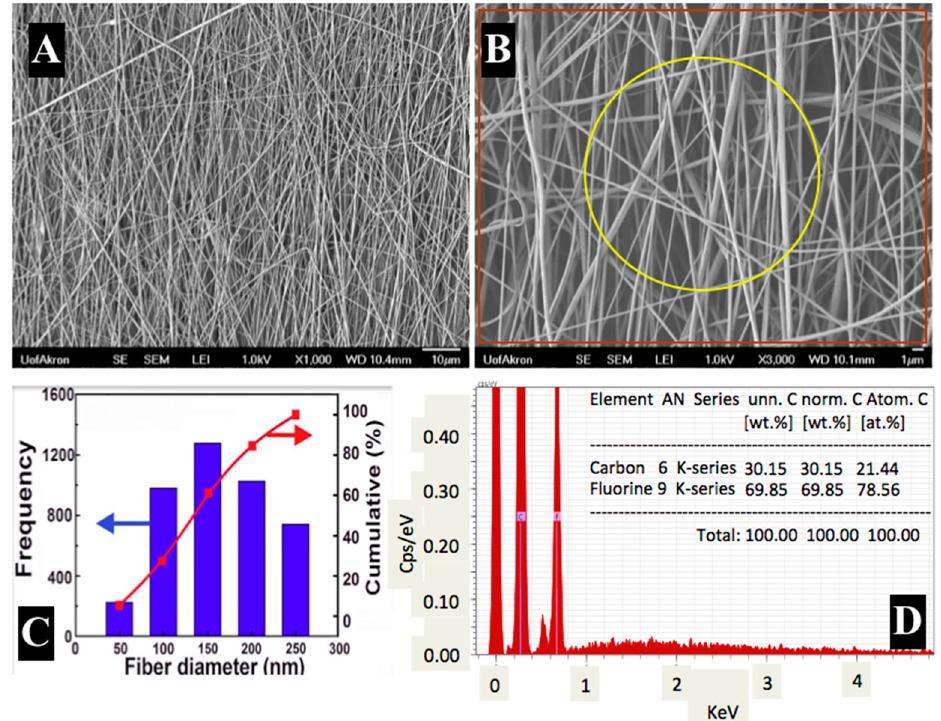
Figure 5. SEM electron micrographs, associated fiber size distributions and EDX elemental compositions of PVDF electrospun fibers. Figure 5A, B are low and high magnification images of PVDF nanofibers, Figure 5C is fiber size distribution and 5D is elemental composition of the electrospun PVDF